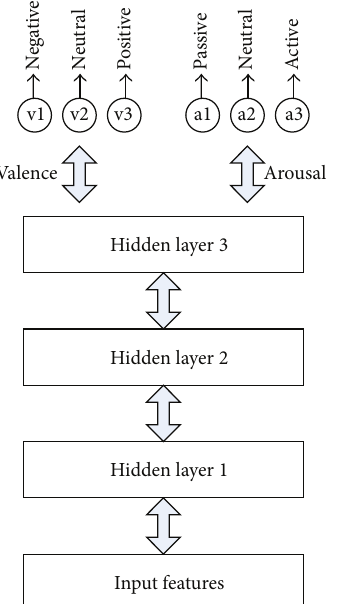
Figure 8: Emotion state classes.